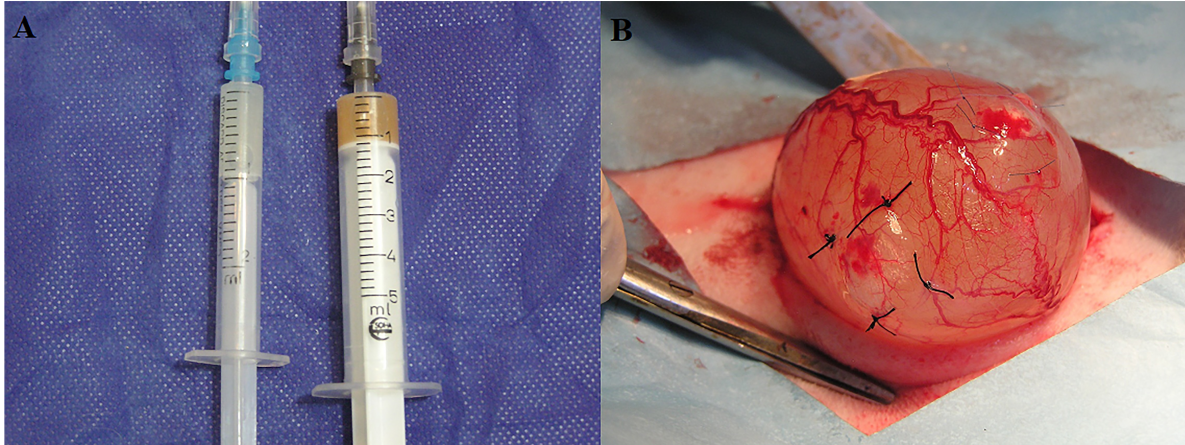
Figure 1 - LPM and LDM supplied in the syringe at the time of injection (A) Injection method of Deflux, LPM, and LDM beneath the mucosa layer of the bladder wall